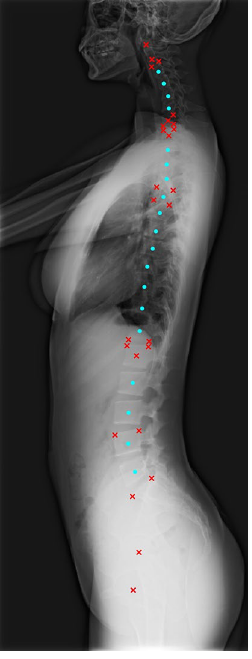
Figure 1. Annotated anatomic landmarks. 45 anatomic landmarks were annotated on a whole-spine lateral radiograph. 26 landmarks related to spinopelvic parameters are highlighted by crosses (in red); the other landmarks, which are at vertebral centres and can be used to determine the spinal curve, are highlighted by solid circles (in cyan). Detailed descriptions for each landmark are presented in the Methods